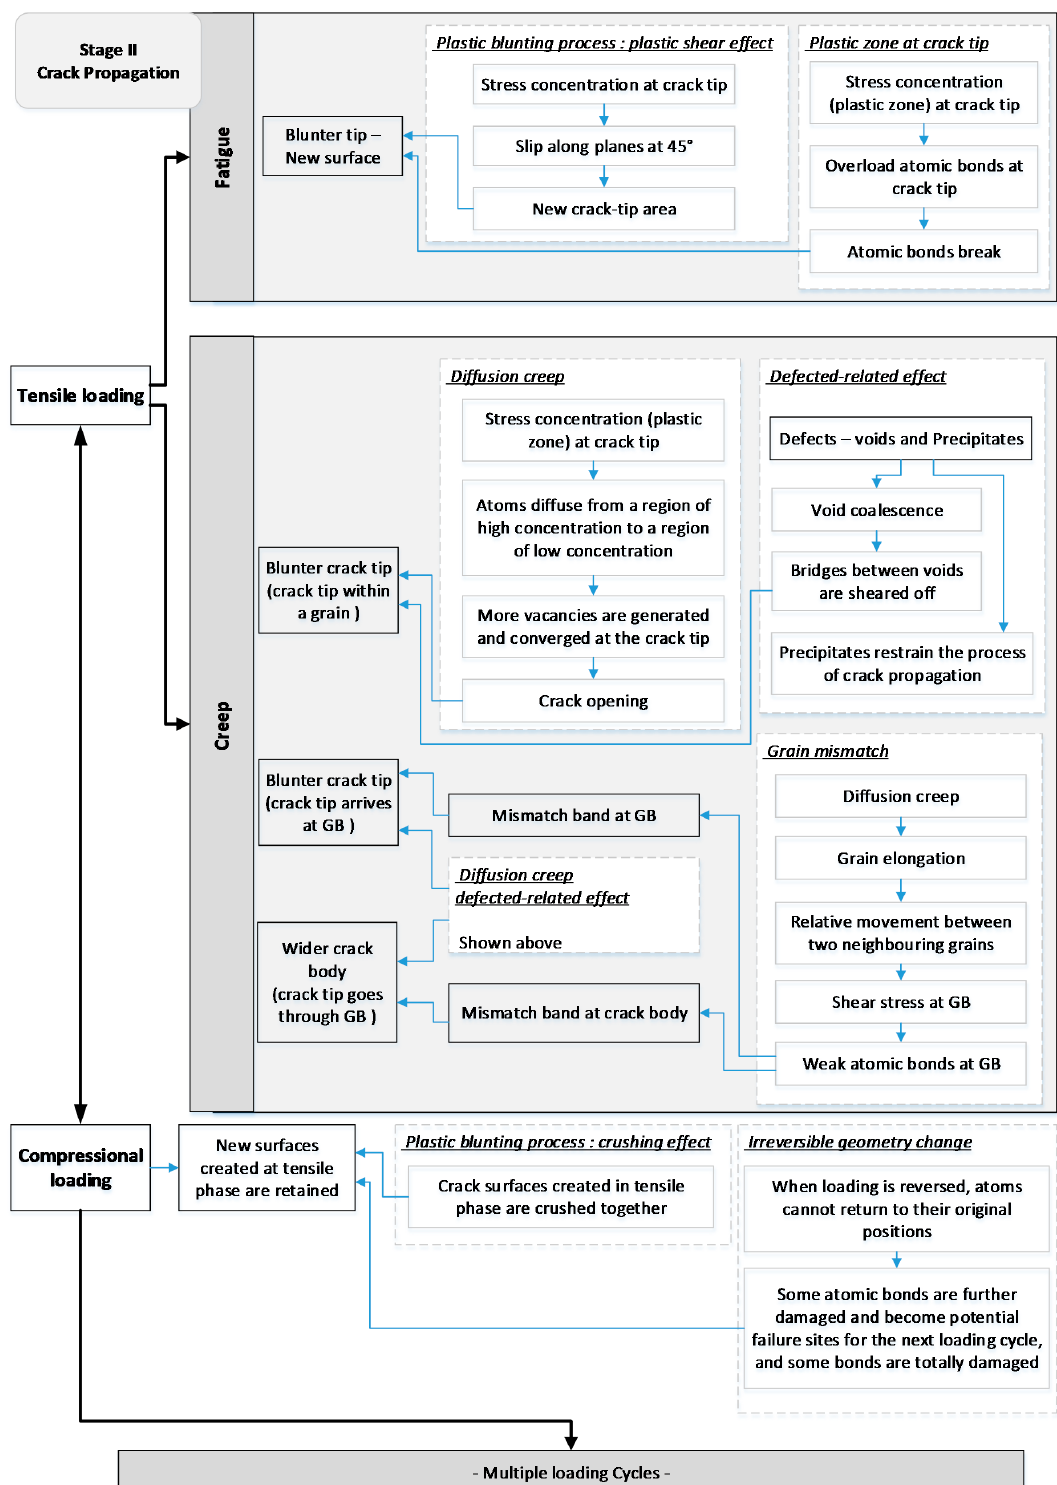
Figure 18. Key elements for one loading cycle in the stage of crack for tension and compression.